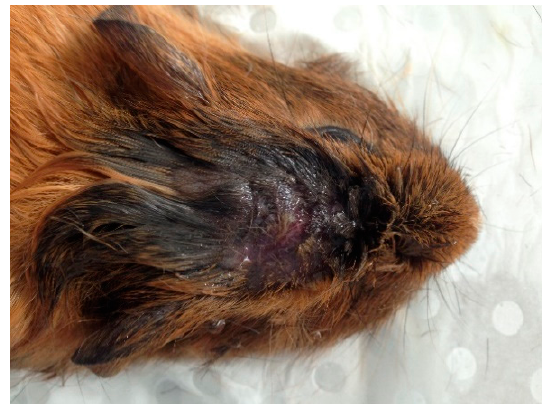
Figure 3. Skin intact from penetrative CB site. Animals 2020 , 10 , x FOR PEER REVIEW